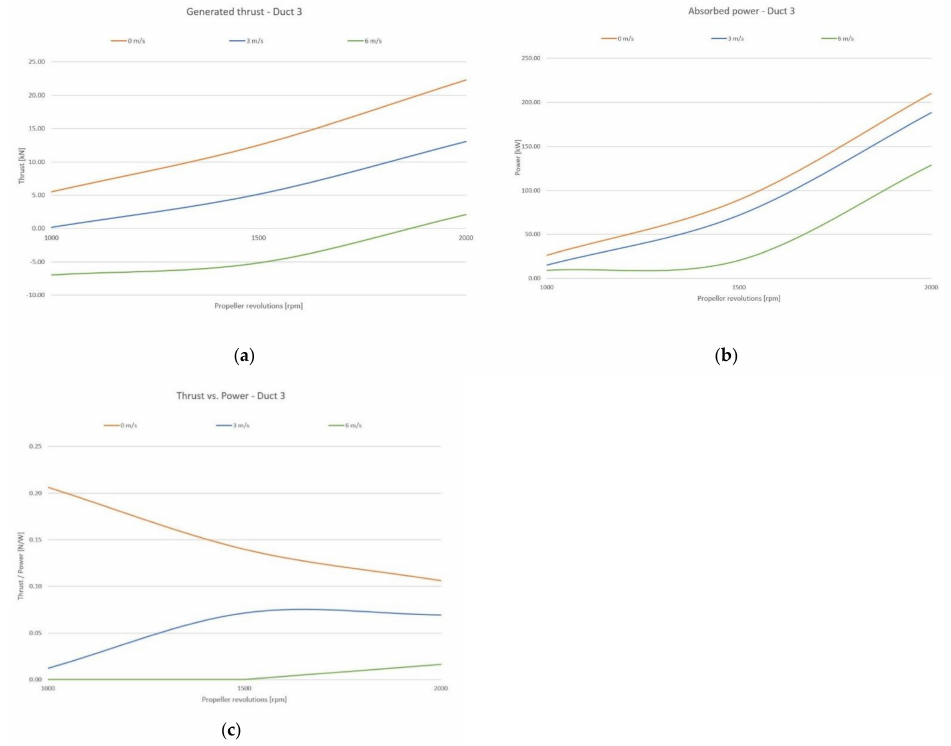
Figure 11. Performance characteristics of propeller with Duct 3. ( a ) Generated thrust for different speeds depending on the propeller speed; ( b ) absorbed power for different speeds depending on propeller speed; ( c ) generated thrust per unit of power absorbed.